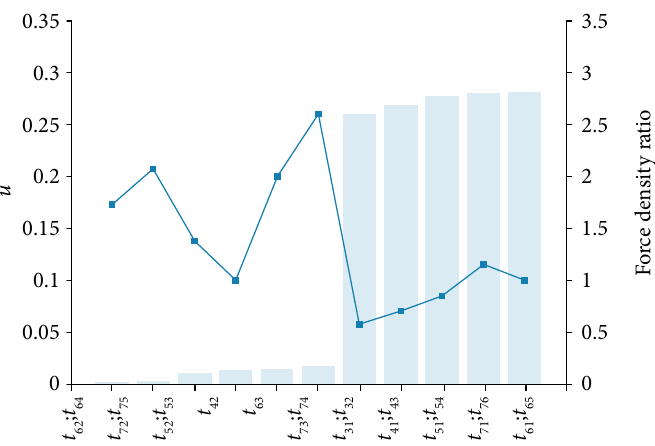
Figure 8. The relationship between utilisation ratio of material strength and force density ratio of each configuration. The parameter u is also related to the ratio of material strength of bars to cables. Figure 9 shows the relationship between parameter u and ratio of material strength of bars to cables when the radius ratio of bar to cable and length–diameter ratio of enveloped cylinder of structure are determined.